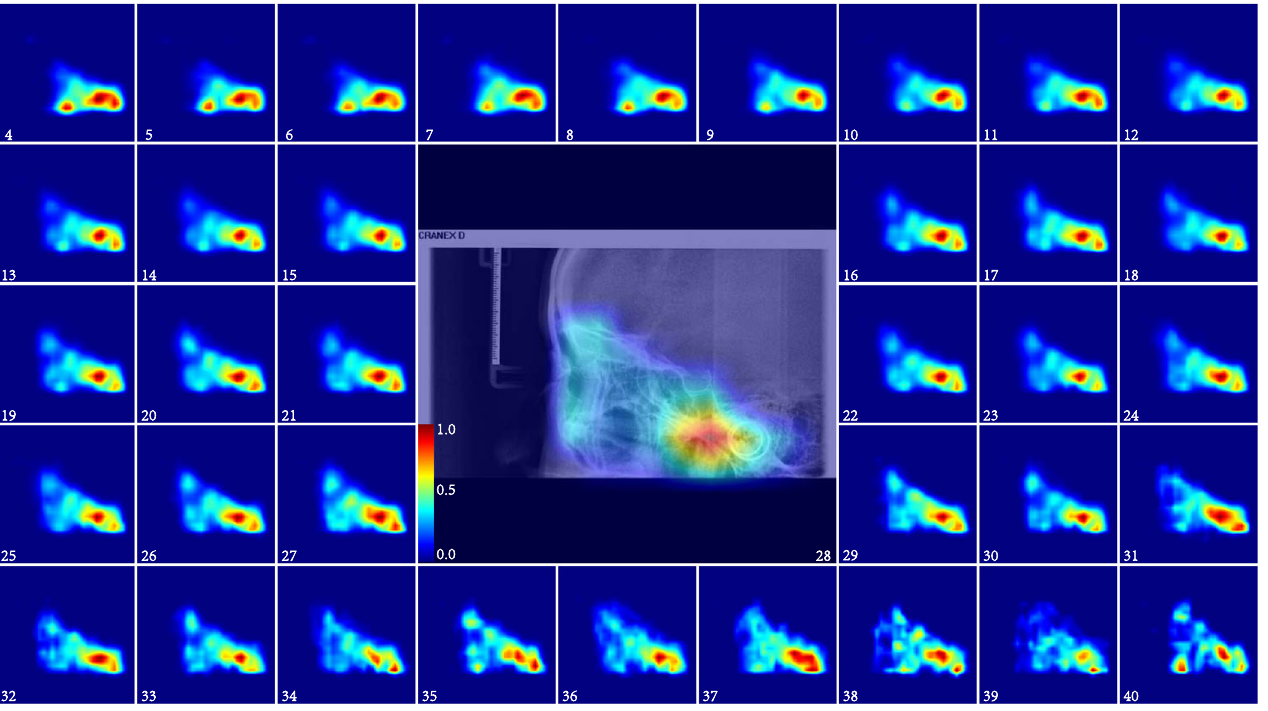
Fig. 4 The ARDA map of the craniofacial region from 4 to 40 years old. The central panel displays the craniofacial region of a randomly selected 28-year-old subject overlaid with its corresponding ageing salience map to show the relative position between the ARDA map and the craniofacial region of the LCR image. Source data are provided as a Source Data fi